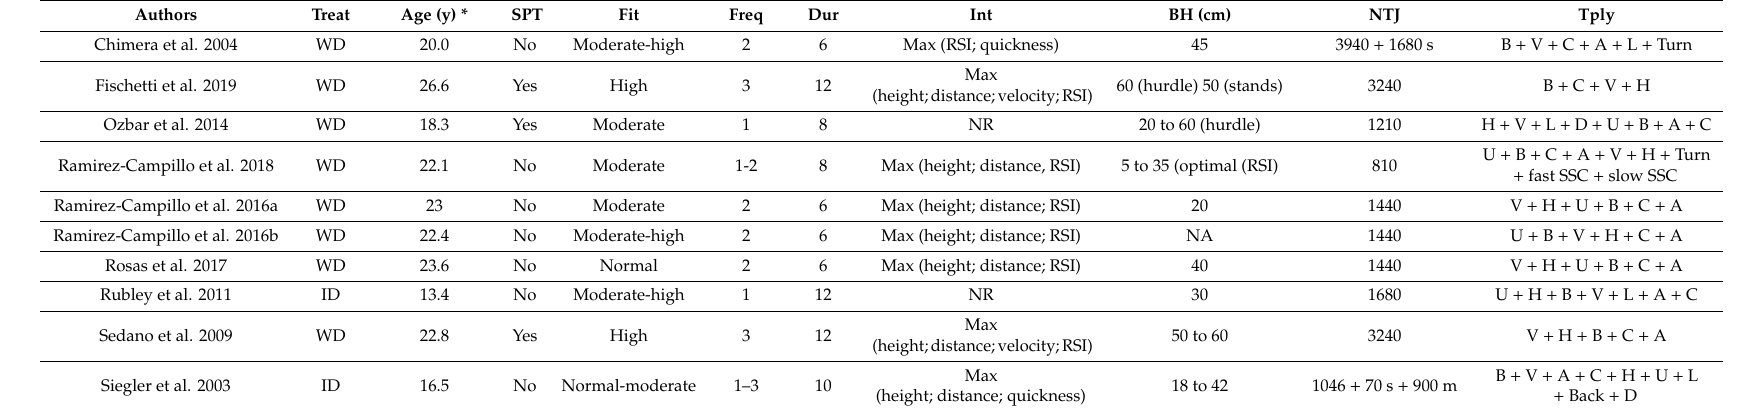
Table 1. Characteristics of included study participants and of PJT